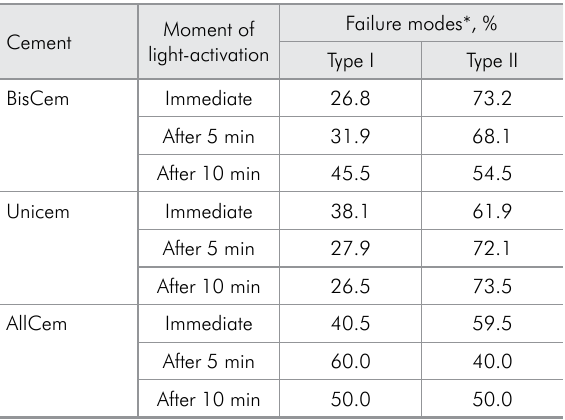
table 3. Distribution of failure modes among groups. Moment of Cement